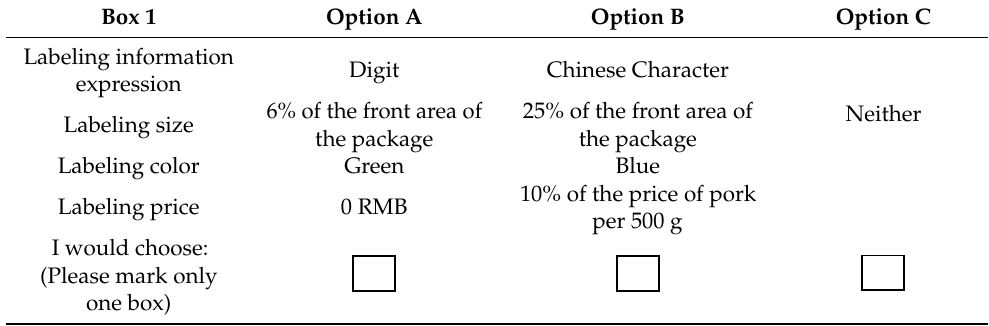
Table 2. An example of a choice set. Box 1 Option A Option B Option C Labeling information Digit Chinese Character expression 6% of the front area of 25% of the front area of Labeling size the package the package Neither Labeling color Green Blue 10% of the price of pork Labeling price 0 RMB per 500